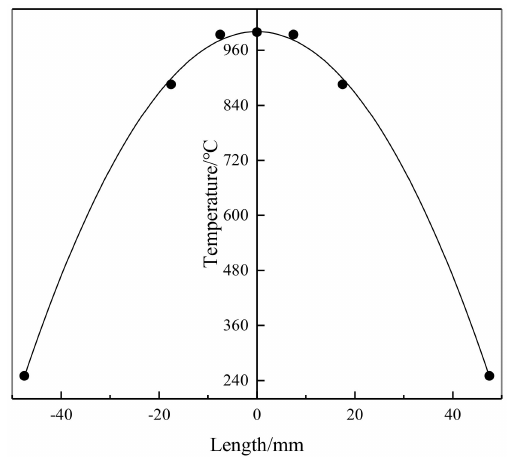
Figure 3. Temperature distribution along length direction of X12 steel at 1000 ◦ C.